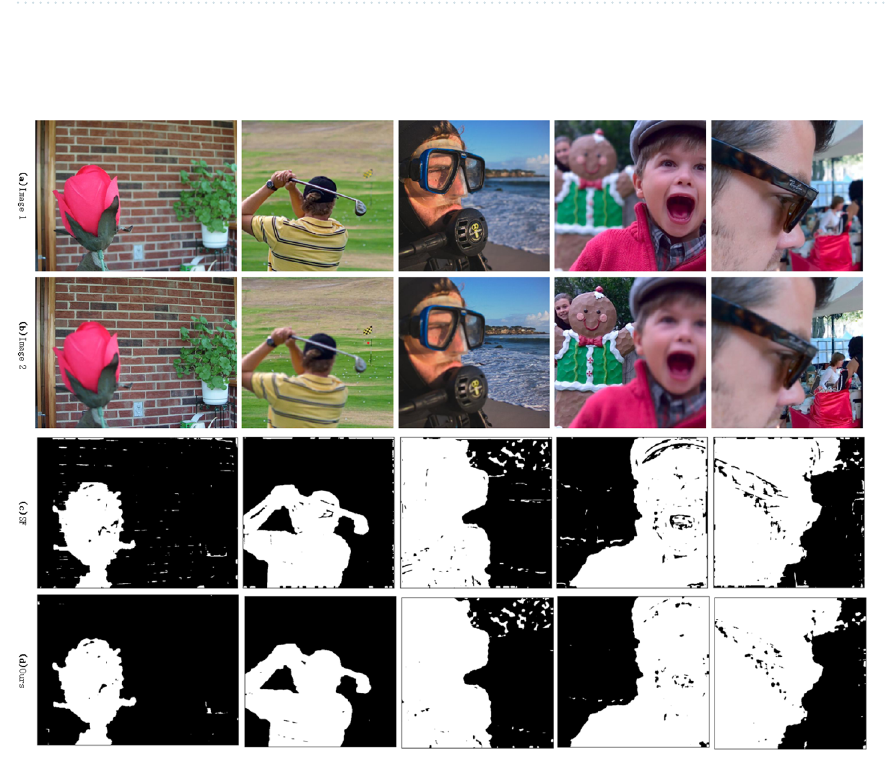
Figure 7. Comparison of fusion strategies 35,36